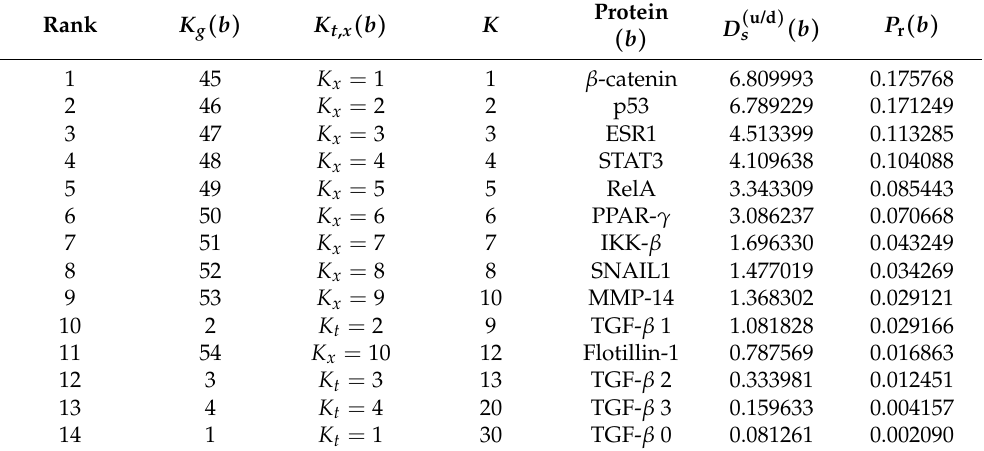
( u/d ) ( b ) = ∑ 44 D ab (i.e., the a -sum is over up- and down-proteins) for Table 3. Values of the sum D s a = 5 b belonging to the TGF- β or the X-proteins subgroups. The list is ordered with respect to decreasing ( u/d ) ( b ) values with the first column giving the corresponding ranking index; the second and third D s columns giving the K g , K t , x indexes; the fourth and fifth columns containing the local PageRank index K and the name of the protein b ; and the sixth and seventh columns giving the values of D and the local PageRank probability P r ( b ) . Both K and P r ( b ) correspond to the group of 54 fibrosis proteins of Table